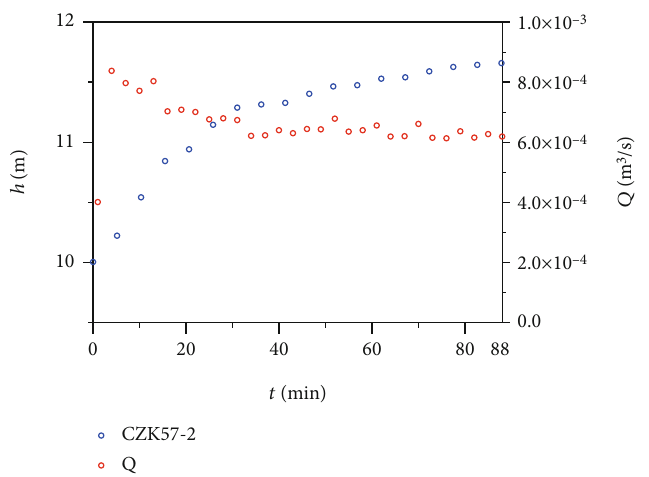
Figure 7: Flow rate of injection borehole and water level of observation borehole CZK57-2.